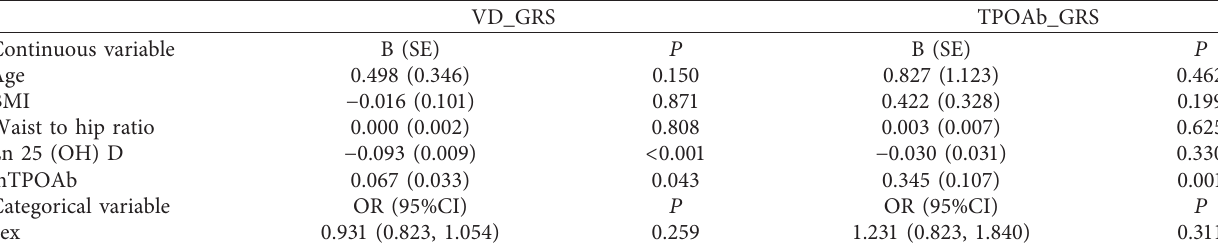
Table 3: Association of the GRSs with confounders.